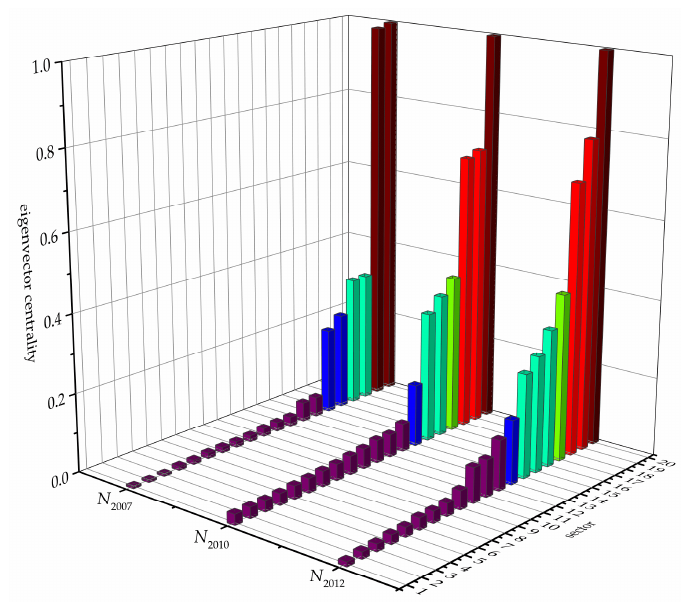
Figure 9. Top 20 sectors in each network in terms of eigenvector centrality values.